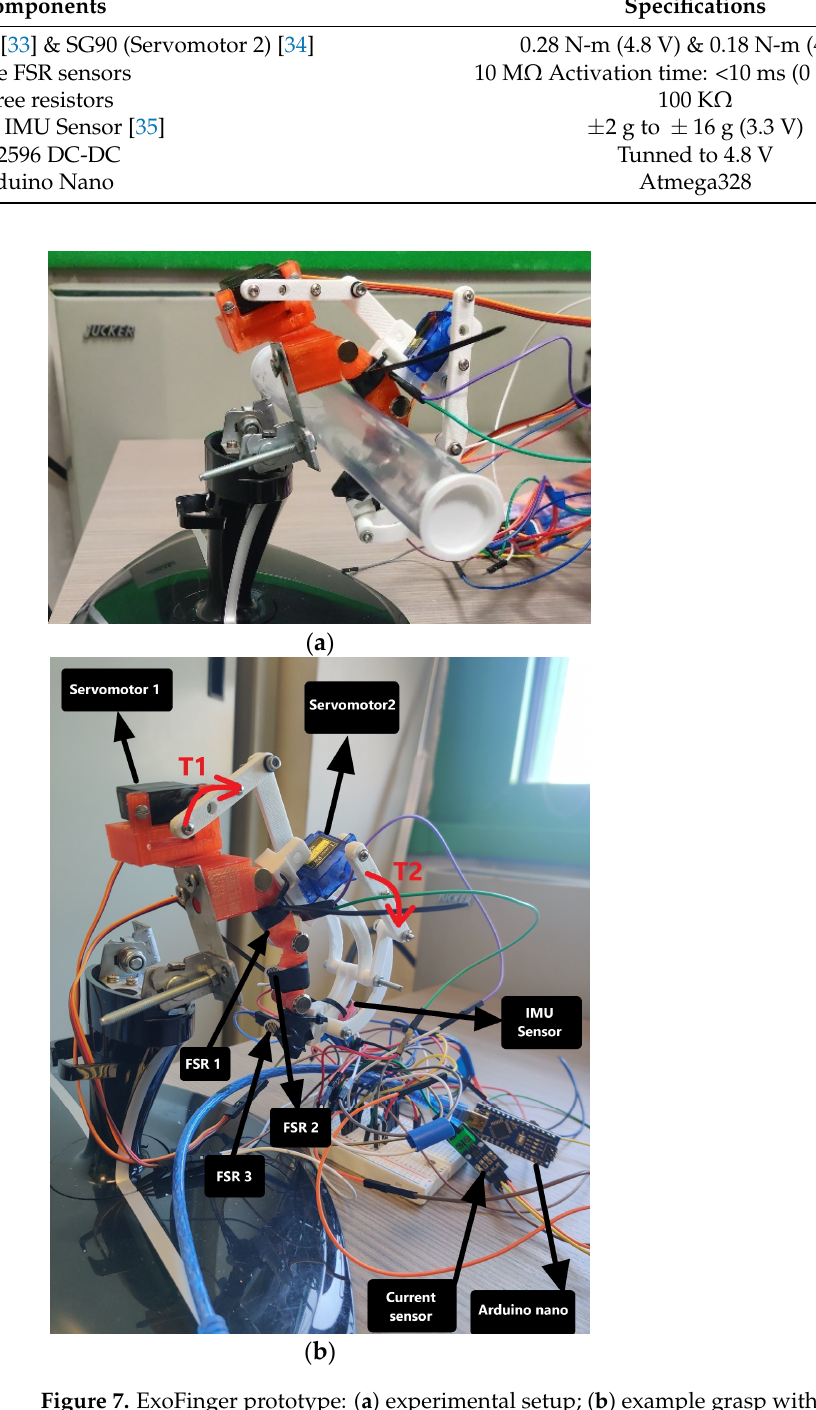
Figure 7. ExoFinger prototype: ( a ) experimental setup; ( b ) example grasp with the exoskeleton.